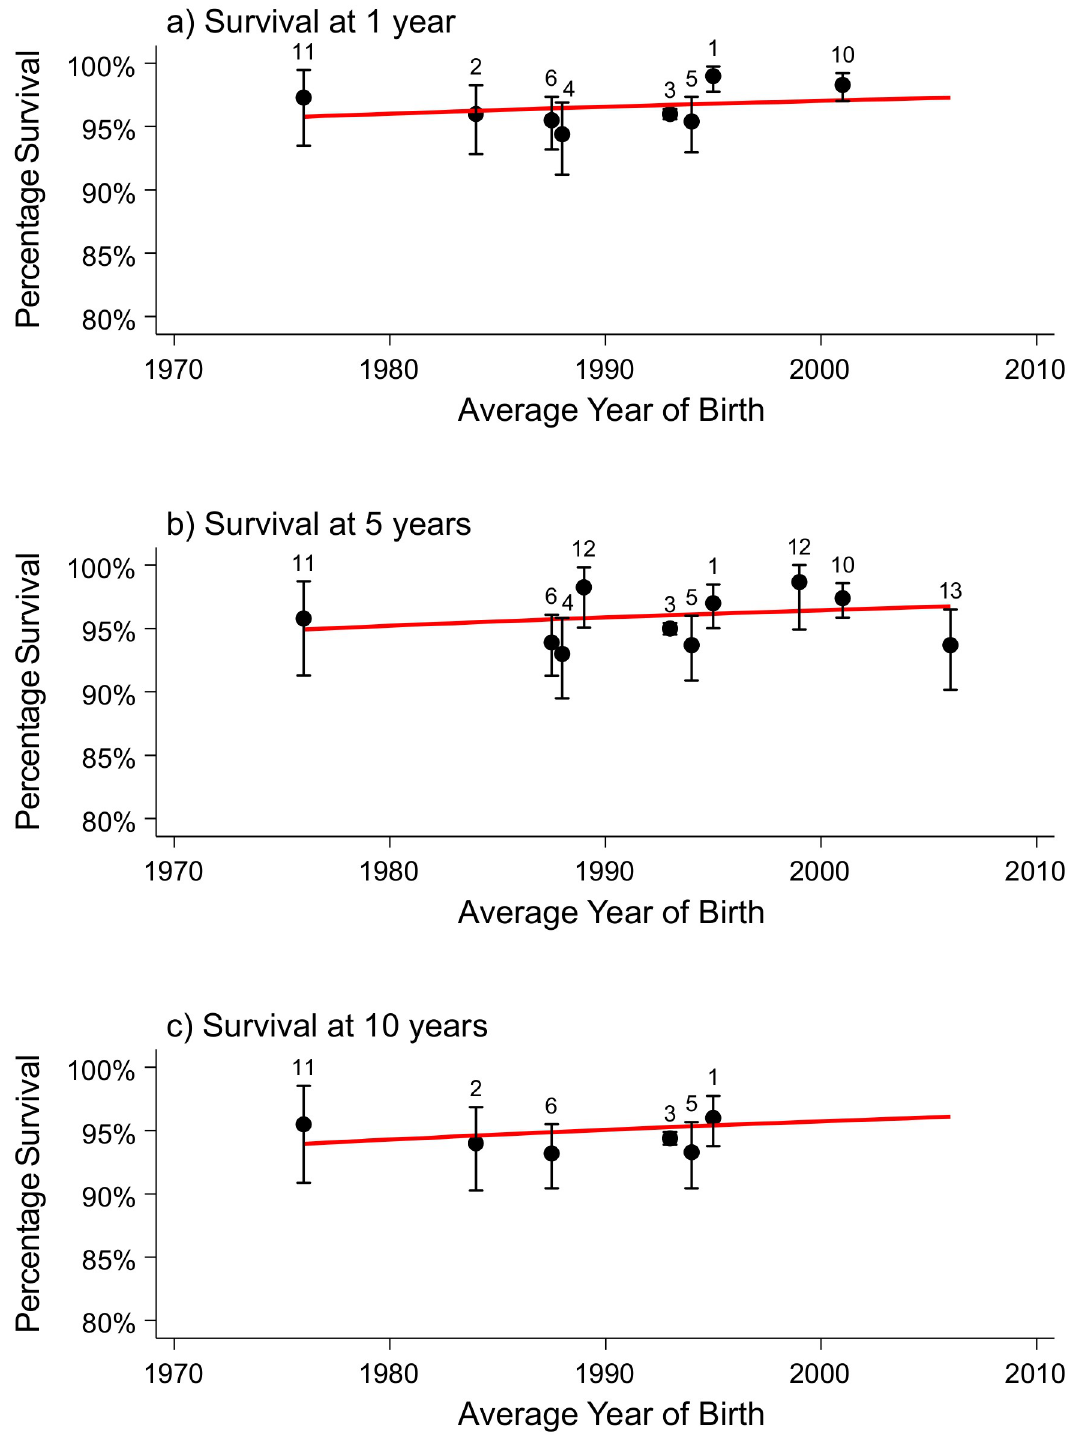
Fig 7. Survival estimates (with 95% confidence intervals) of children with Down syndrome associated with congenital heart defect at 1 (a), 5 (b), and 10 (c) years of age over time (11 birth cohorts from 10 studies). The numbers at survival points indicate the included study, which may appear more than once if survival was reported for more than one birth cohort: 1 –Glasson, 2016, Western Australia; 2 –Hayes, 1997, Ireland; 3 –Kucik, 2013, USA; 4 –Leonard, 2000, Western Australia; 5 –Rankin, 2012, Northern England; 6 –Rasmussen, 2006, Atlanta, USA; 10 –Brodwall, 2018, Norway; 11 –Frid, 1999, northern Sweden; 12 –Halliday, 2009, Victoria, Australia, 13 –Schneuer, 2019, New South Wales, Australia.